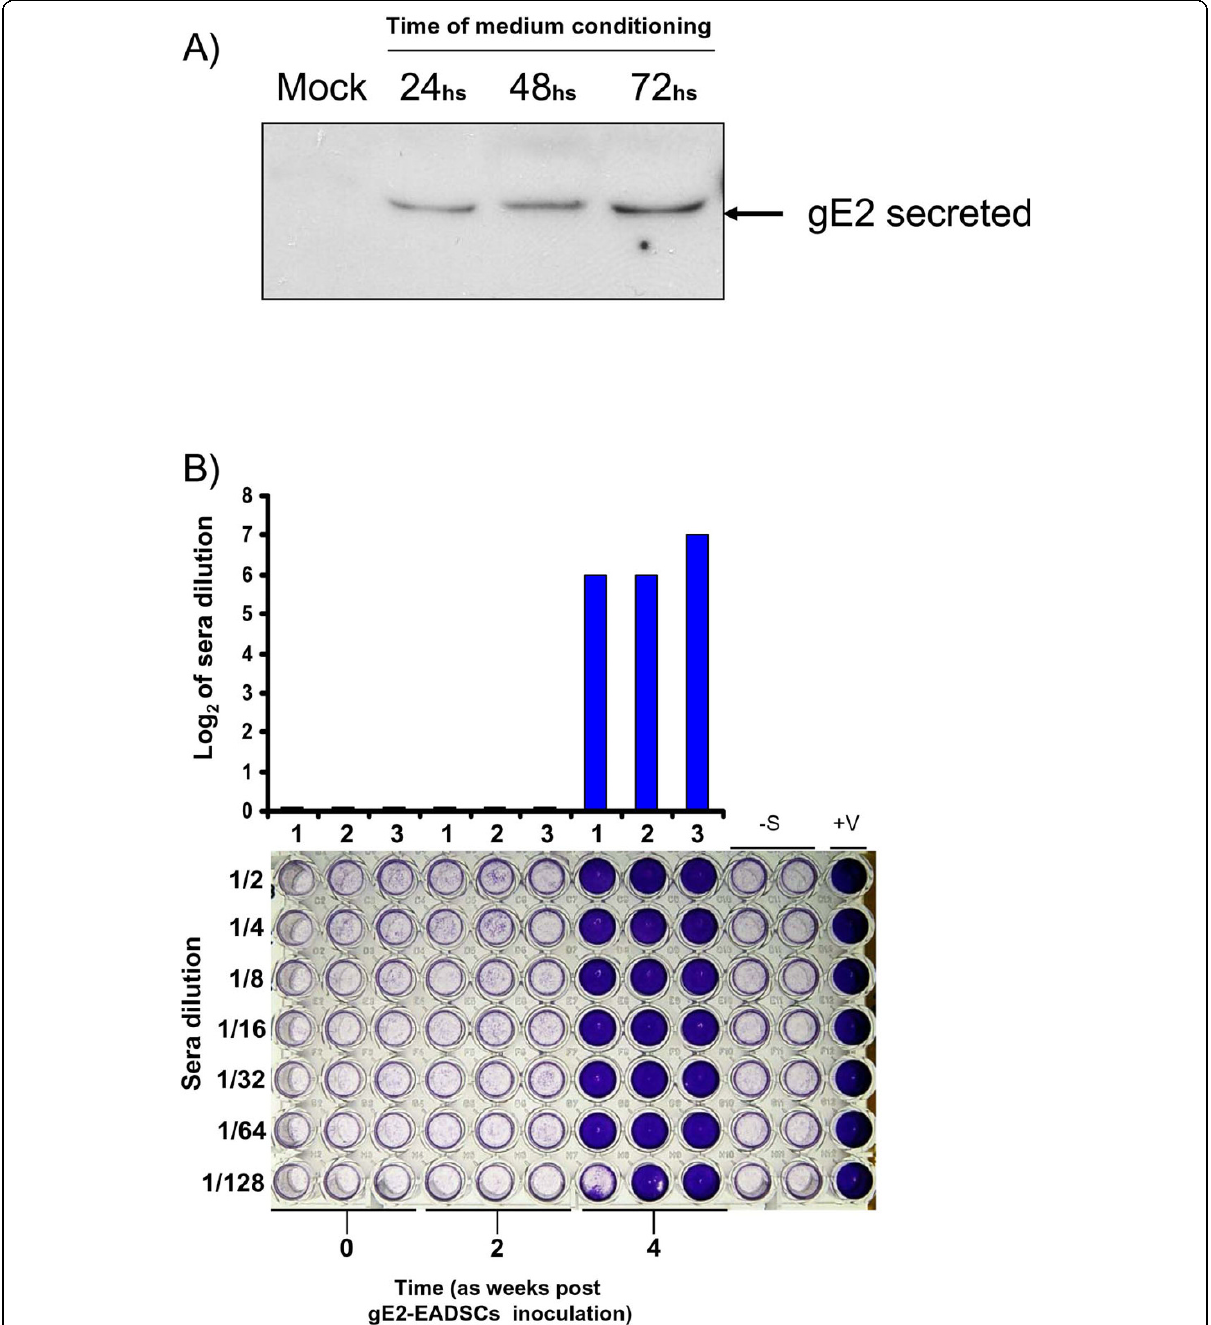
Figure 7 Paracrine delivery of secreted protein by transgenized EADSCs in vivo . A) Western immunoblotting at 24, 48 and 72 h of gE2- EADSCs conditioned medium and compared to 72 h conditioned medium coming from mock-transfected and selected EADSCs. B) Humoral immune responses of 3 horses (1, 2 and 3) inoculated with gE2-EADSCs. Preimmune sera (time 0), sera at 2 weeks post gE2-EADSCs inoculation (time 2) and sera at 4 weeks post gE2-EADSCs inoculation (time 4 or time 2 from the second post gE2-EADSCs inoculation). Anti BVDV antibodies were detected by serum neutralization (SN) test. SN antibodies were expressed as the reciprocal of the highest dilution of the serum that inhibited the development of virus-induced CPE in MDBK cells. Virus neutralization (VN) titers of >1 (log 2 ) were considered to be positive. Each value represents the response of each horse. Multiwells plate image with respective horse sera dilution, where crystal violet staining allows macroscopic evaluation of the integrity (violet wells) or the destruction (clear transparent wells) of the cell monolayer. The test was repeated three times and the same result was obtained. Controls were established in the absence of sera (-S) or with sera coming from BVDV infected